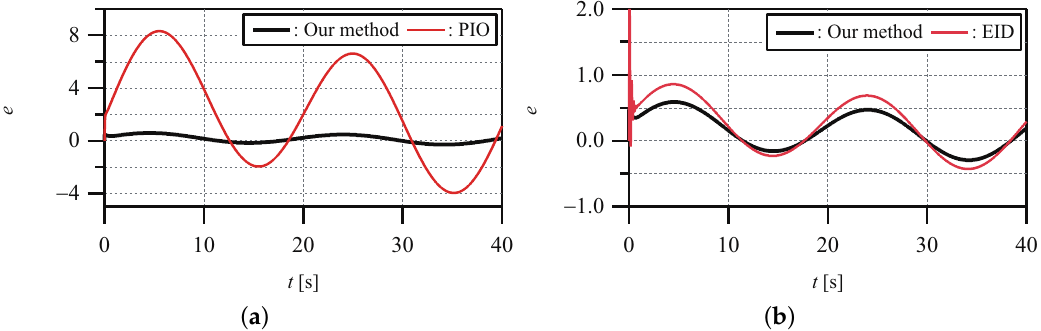
Figure 7. Comparison of IEID and PIO and conventional EID method. ( a ) Outputs of IEID and PIO method; ( b ) Outputs of IEID and conventional EID